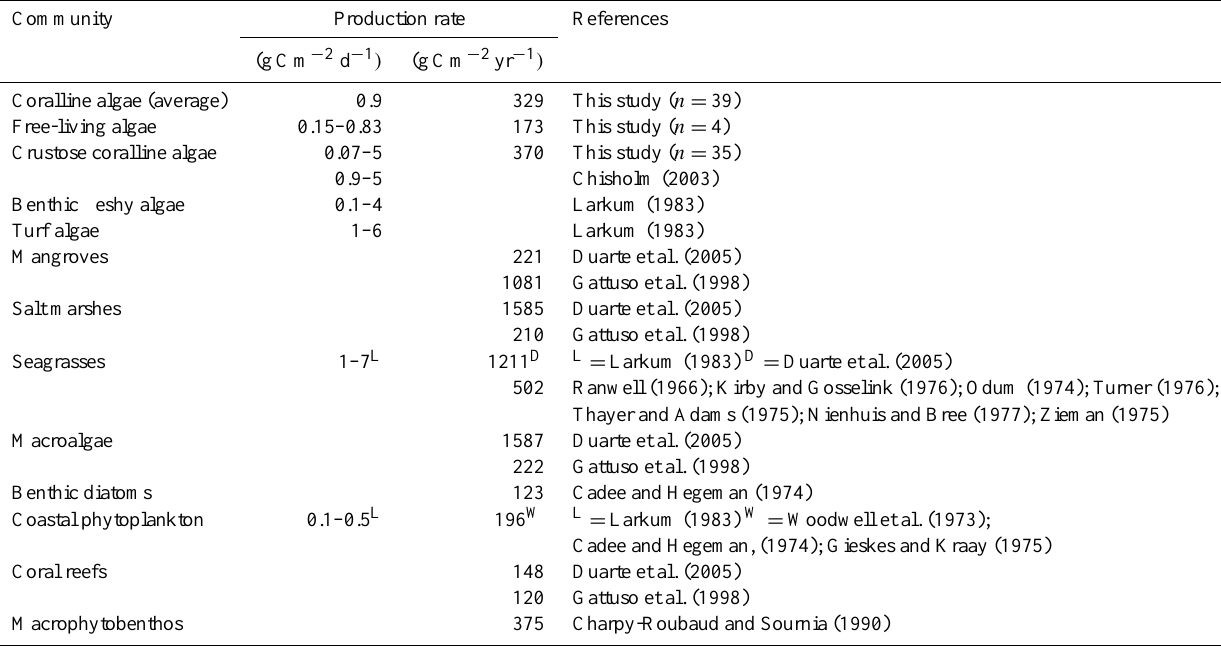
Table 2. The global average production rates of autotrophic coastal communities. Macroalgae in Gattuso et al. (1998) were macrophyte- dominated. Macrophytobenthic communities in Charpy-Roubaud and Sournia (1990) included brown algae, seagrasses, mangroves and salt